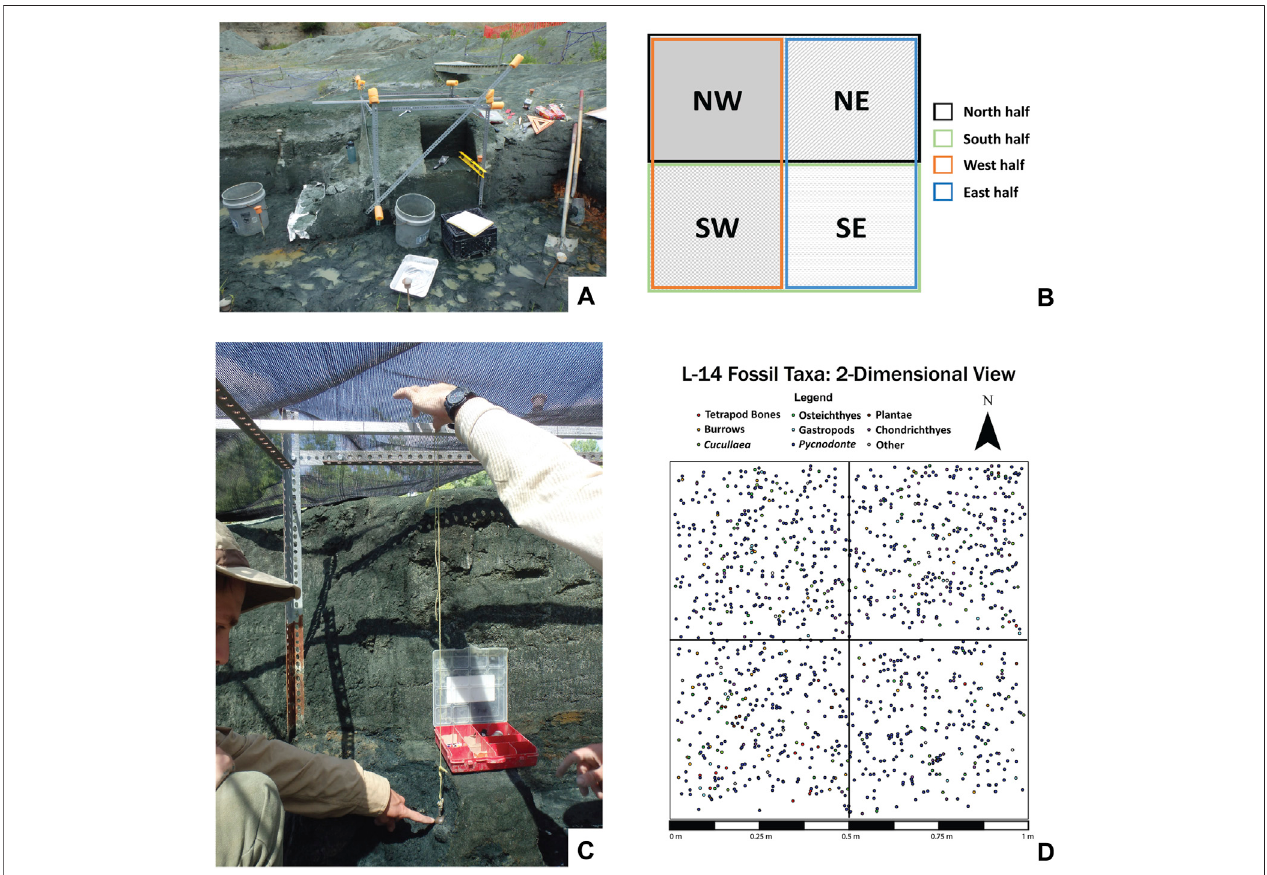
FIGURE 1 | Overview of our excavation area, mapping apparatus, data partitioning system, and recovered fossils. (A) The metal frame installed around our in- progress excavation. (B) Partitioning of our excavation area by halves and quadrants. In a second stage of analyses, fossil occurrences were binned within these subregions to examine spatial variations in the geometry of fossil layers (see main text for further details). (C) Example of our three-dimensional mapping technique, in whichaplum bobsuspended from ascaled, movable bar acrossthetop ofthemetalframewasused tomeasure down tothehighest point ofafossil. In thiscase, anexcavatorispointingtothefossil,a Cucullaea steinkern,whosepositionisbeingmeasured. (D) Thedigitizedcentroidsofallcollectedfossilsinmapview,colorcoded by taxonomic category as shown in the legend.